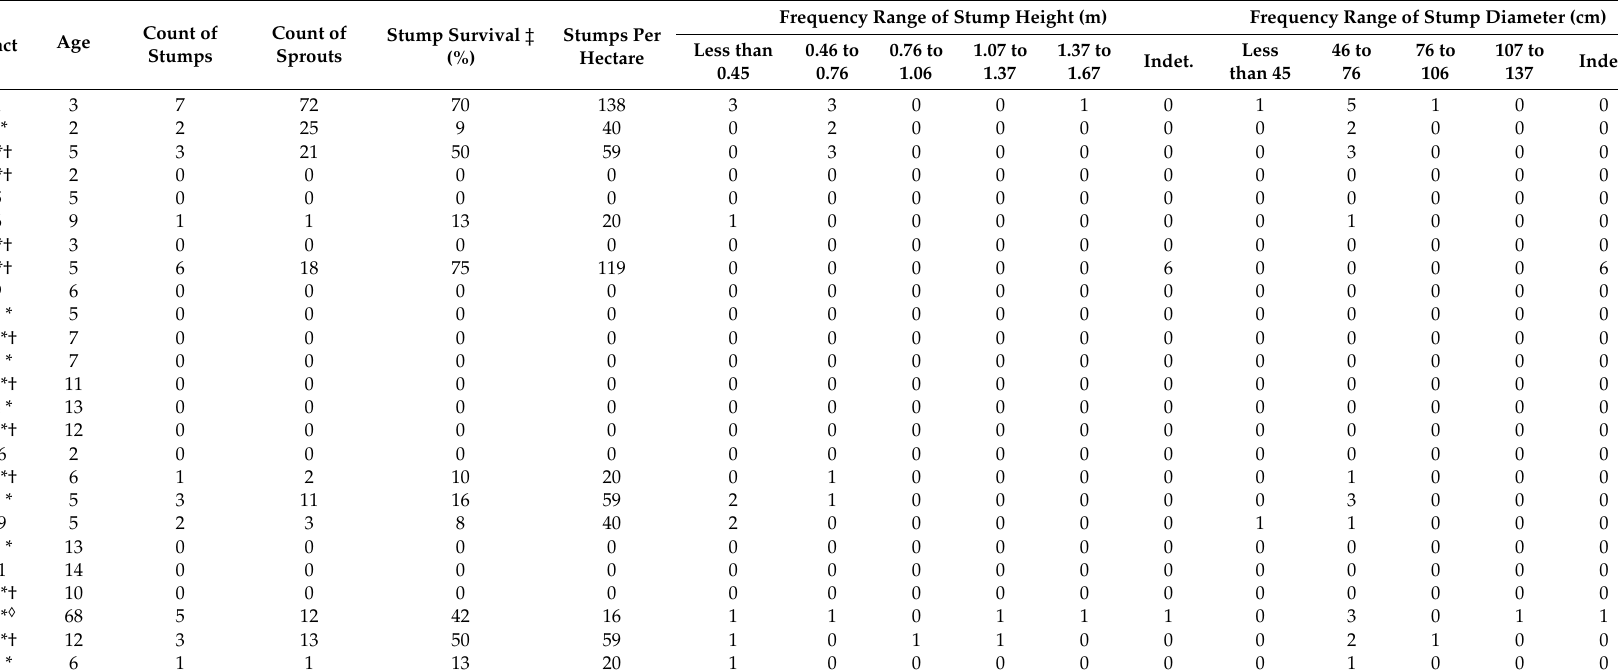
Table 5. Count, height, and diameter of live cypress ( Taxodium distichum ) stumps and stump survival by each of the 25 tracts